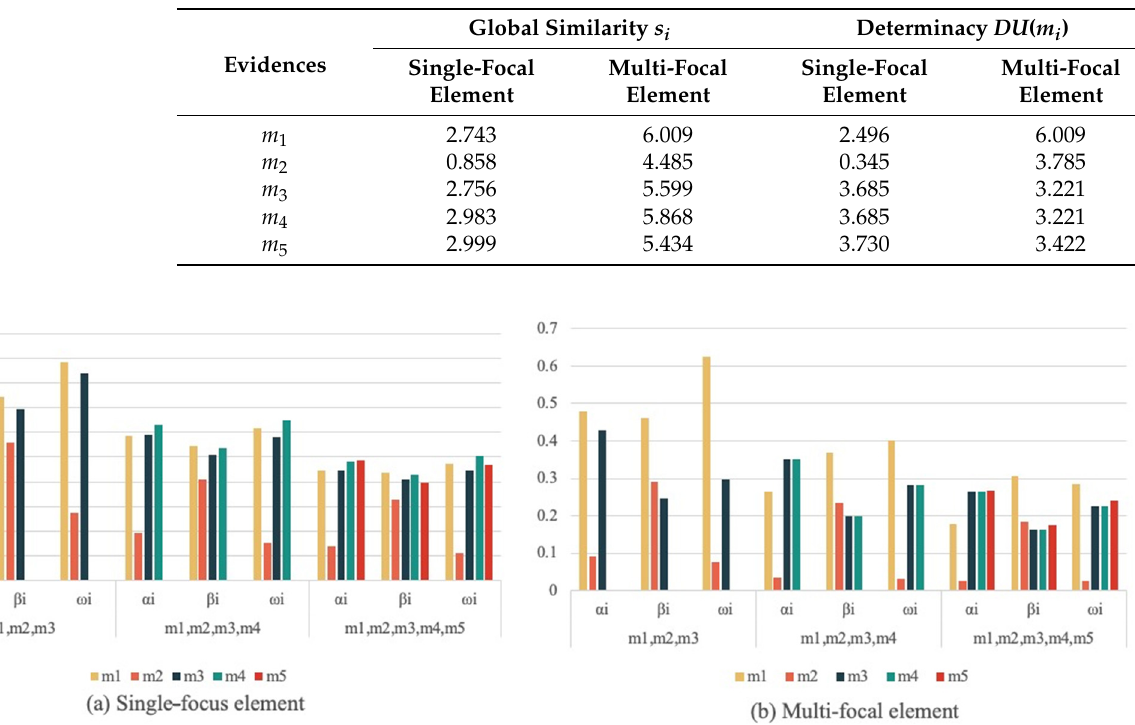
Figure 5. Weight of evidence under different amounts of evidence. ( a ) Single-focal element evidence weights. ( b ) Multi-focal element evidence